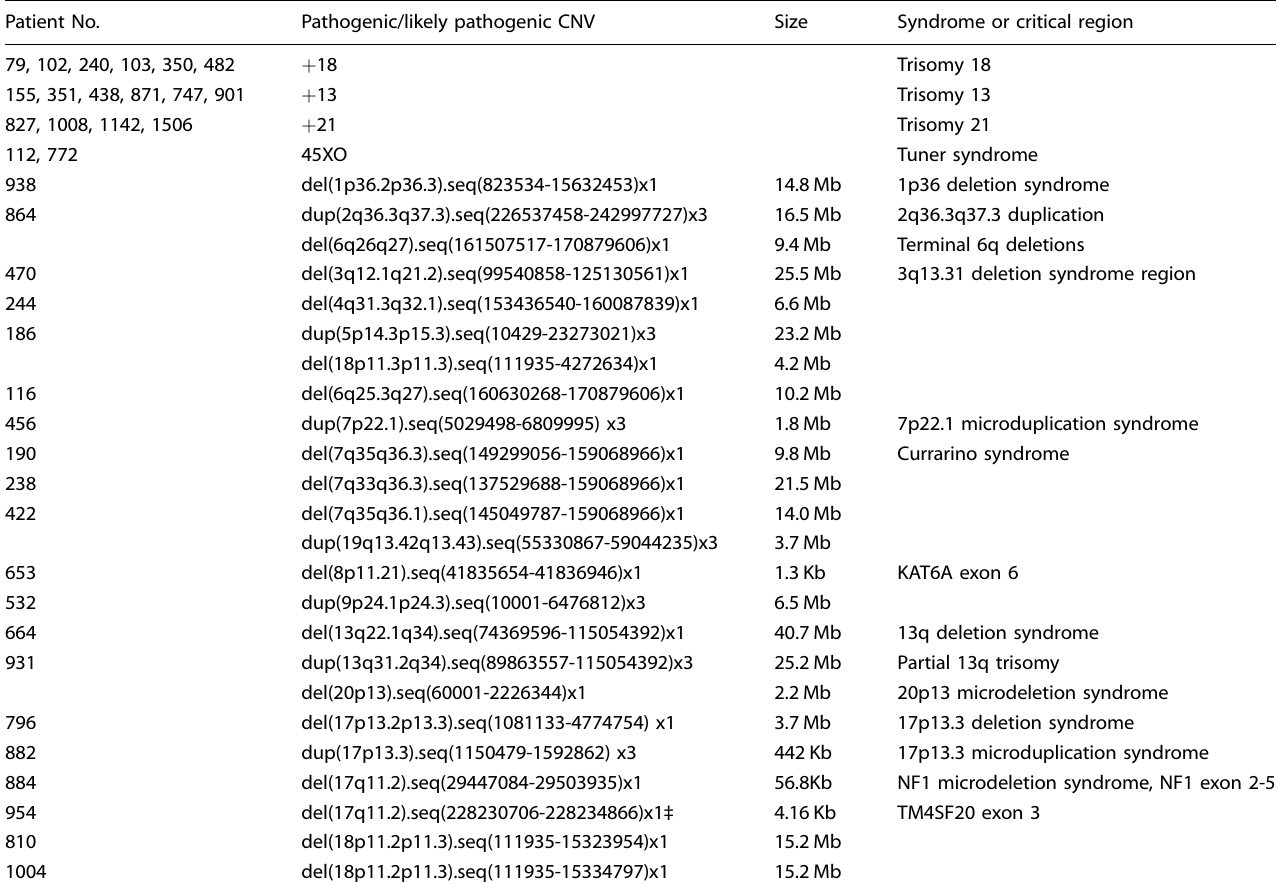
Table 1. Chromosomal anomalies, diagnostic CNVs, and intragenic CNVs. Patient